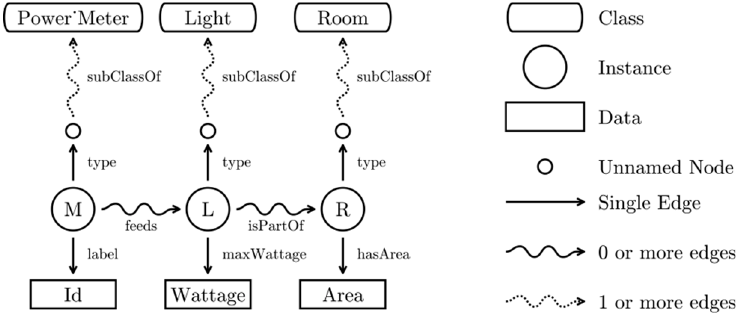
Figure 7. Substructure of Brick model relevant querying, showing how meters (M), lights (L), and rooms (R) are linked.